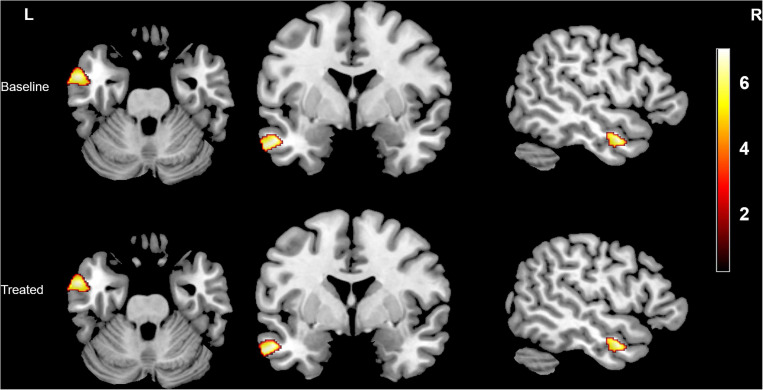
Intergroup differences in WMV between the tinnitus patients without HL and HCs before and after sound therapy. At baseline, compared with the HCs, the patients with tinnitus without HL exhibited reduced WMV in the left MTG (corrected at non-stationary cluster level with FWE p < 0.05). After sound therapy (treated), the brain region with decreased WMV was still the same area, but the trend in the WMV reduction had diminished (uncorrected). HL, hearing loss, HC, healthy control, MTG, middle temporal gyrus, FWE, family wise error, WMV, white matter volume. The color bar represents the extent of reduction in WMV.